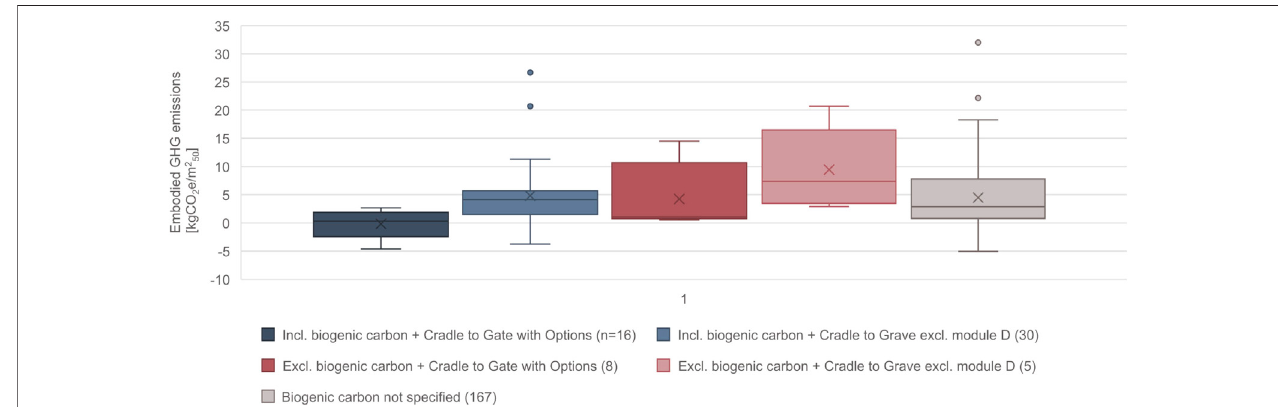
FIGURE6| EmbodiedGHGemissionsdistributedonapproachtobiogeniccarboncountingandsystemboundaries.Thedotsintheplotindicatetheoutliersofthe dataset.Theboxesandthelinewithintheboxesindicatethequartilesofthedataset(25percentile,50percentile(median)and75percentile).The x indicatestheaverage. The error bars outside the boxes indicate the deviation in the